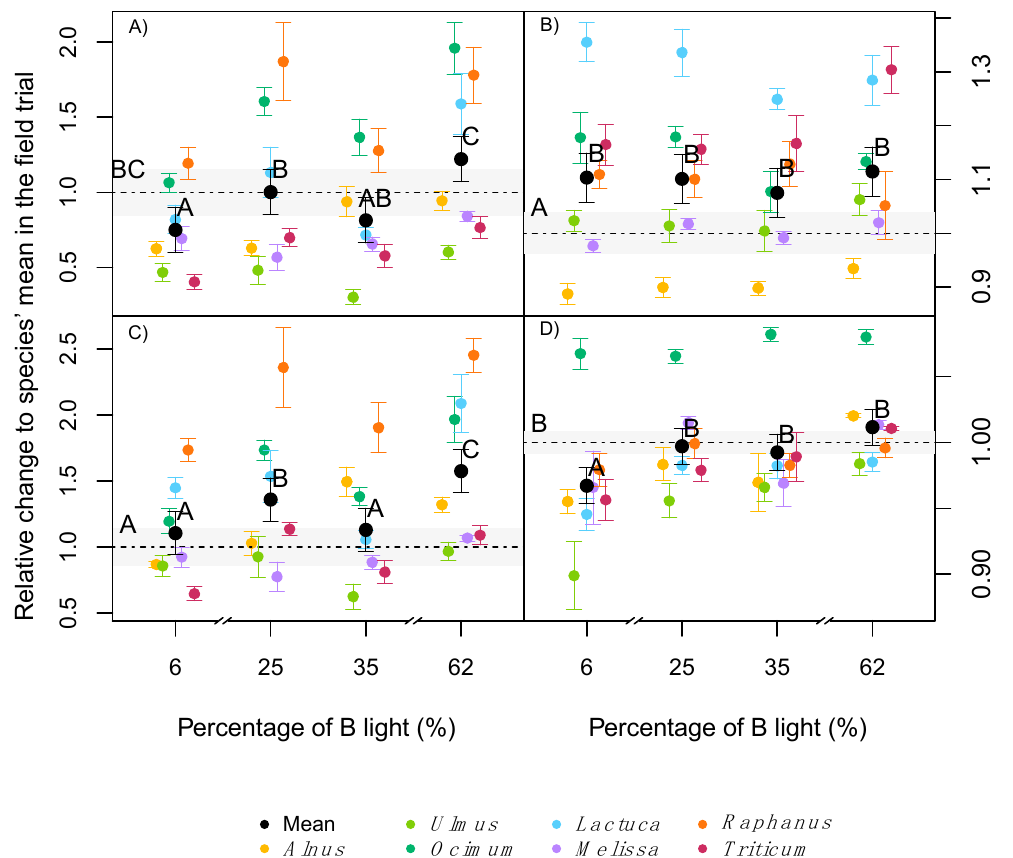
Figure 4. Fold change on Chlorophyll a ( A ), Chlorophyll a:b ratio ( B ), carotenoids content ( C ) and Fv / Fm values ( D ) relative to the average value of the field trial (dotted line). Coloured dots are the average of each species in both experiments runs ( n = 18), the black dots are the average values across all 7 species ( n = 126). Error bars indicate the standard errors. The grey area corresponds to the standard error of the field trial. Di ff erent letters indicate statistically di ff erence between groups with experiment replicate and species as a random e ff